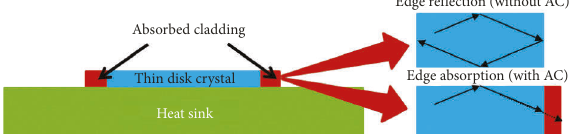
Figure 3: The scheme of the thin disk crystal with or without